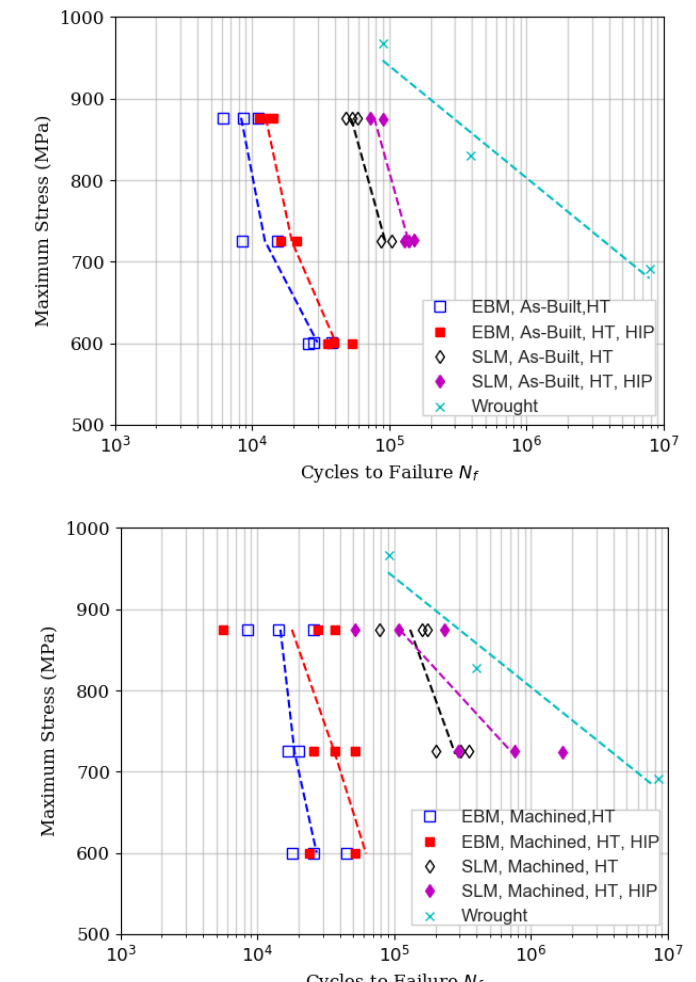
Figure 31: Comparison of S-N curves of SLM IN718 for (a) as-built specimen and (b) machined specimen